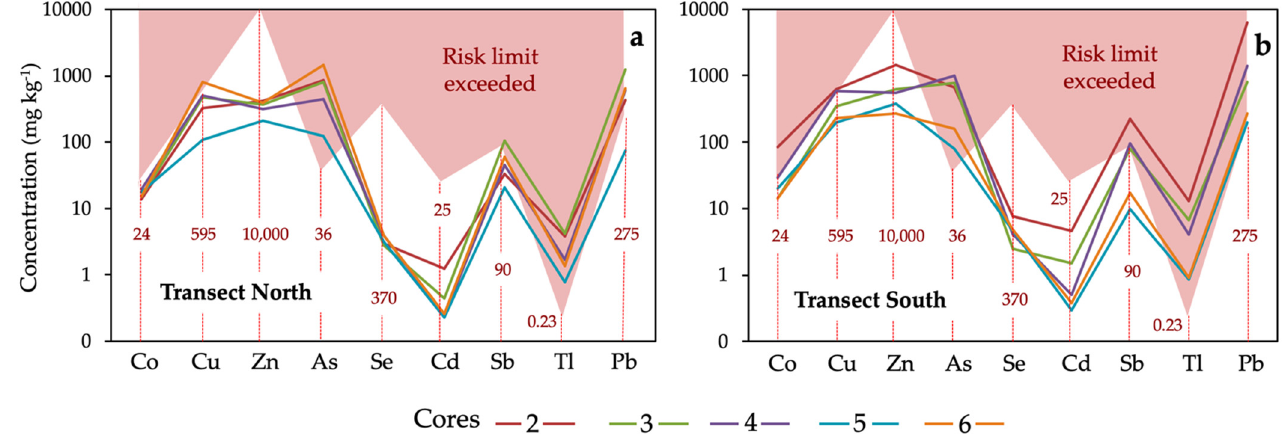
Figure 10. Median concentrations of trace elements in the soil cores collected in each sampling site of the north transect ( a ) and south transect ( b ). The red dashed vertical lines indicate the regulatory guidance values for soils of southern Spain [46], above which adverse effects on human health may